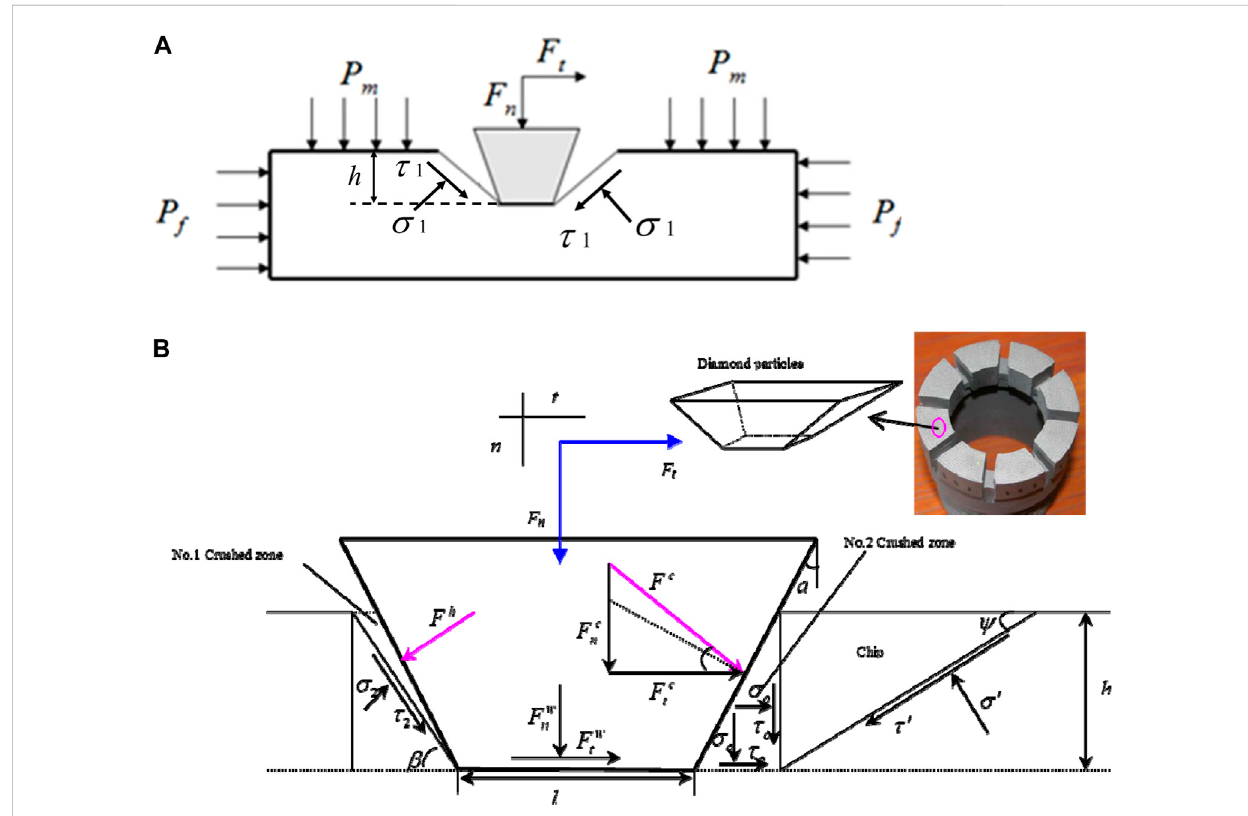
FIGURE 1 The bottom of drilling hole stress analysis (A) and geometry and mechanism of the acting forces in the proposed analytical model (B) .